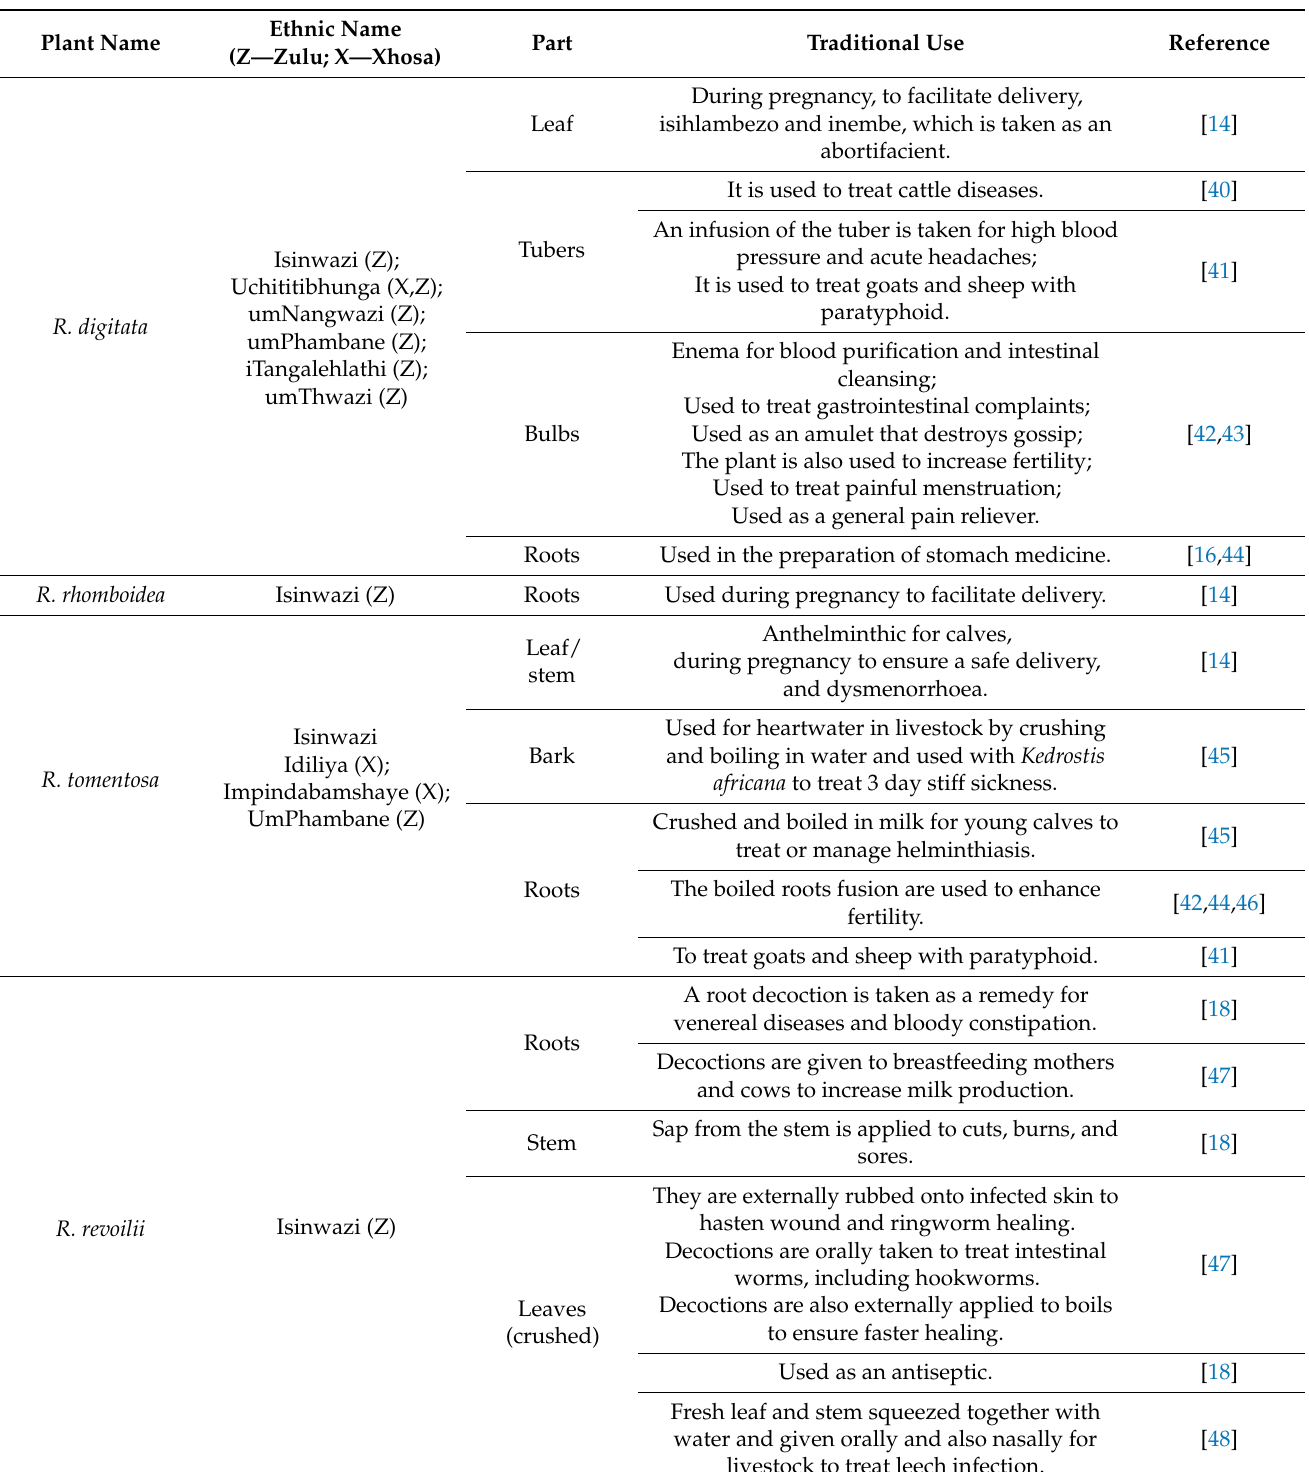
Table 3. Traditional medicinal uses reported for Rhoicissus